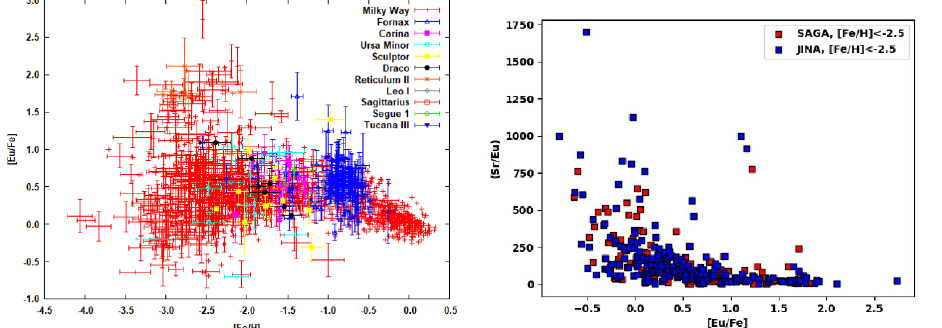
Figure 1. Left: [Eu / Fe] ratios of 1572 stars with Eu detections from the SAGA database [16]. A hugh scatter can be observed before at about [Fe / H] = -2 an averaging (smaller spread) sets in, which continues with a di ff erent gradient when SNe Ia start to contribute at -1. Right: Sr / Eu ratios for all stars with [Fe / H < -2.5, which show a drastic change at about [Eu / Fe] = 0-0.3, i.e. the division between limited-r stars and r-enriched stars [for these observational classifications and the definition of actinide boost stars see e.g. 17–26]. (Notice that some points are identical for SAGA and JINA and only the entry plotted for JINA - in blue – is visible, especially the value of about 1100 for [Eu / Fe] ≈